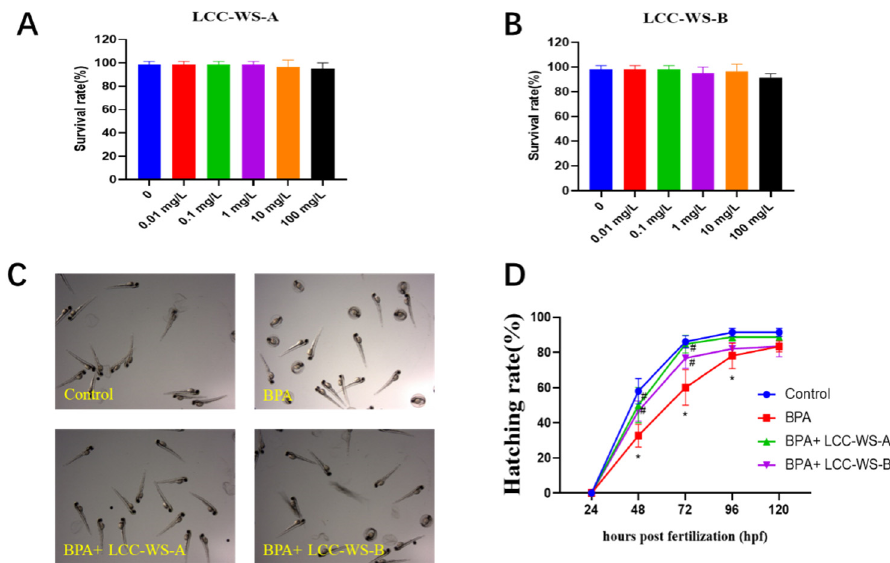
Figure 2. Effects of LCC-WS-A and LCC-WS-B on BPA toxicity in developing zebrafish. Survival rate following LCC-WS-A ( A ) and LCC-WS-B ( B ) treatment. Representative images of the hatched zebrafish larvae in different treatment groups at 72 hpf ( C ). Statistical results of the hatching rate of zebrafish ( D ). * p < 0.05, compared with the control group. # p < 0.05, compared with BPA-treated group.